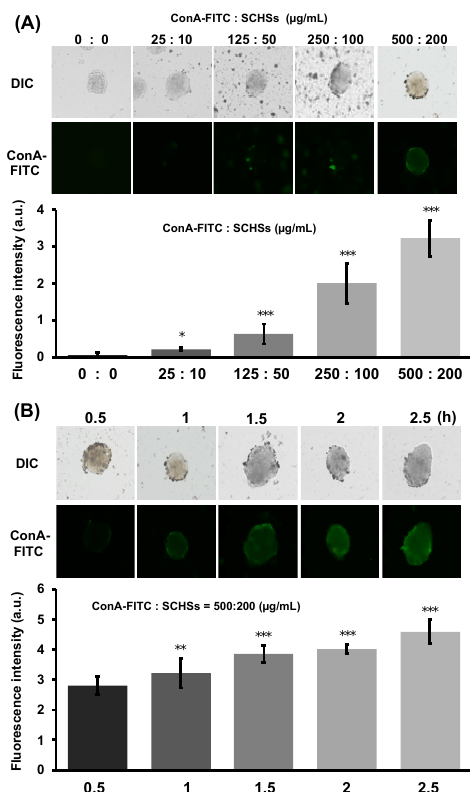
Figure 6. Evaluation of the proper proportion of conjugated ConA-FITC to SCHSs and the time it is exposed to MCAs. ( A ) FITC-labeled ConA (ConA-FITC) conjugated with SCHSs showing an increased binding ability to MCAs when the concentration was increased. ( B ) Time evaluated for binding of ConA-FITC-SCHSs to MCAs.